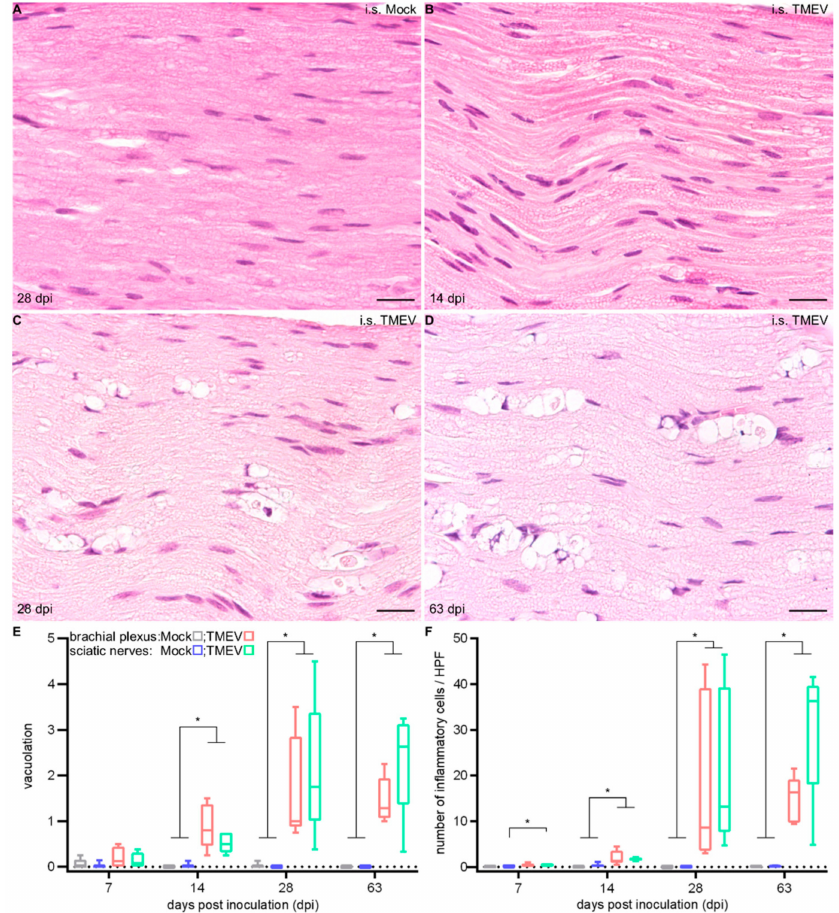
Figure 5. Histopathogical examination of the peripheral nerve (PN) at 28 days post i.s. mock-injection ( A ) and at 14 ( B ), 28 ( C ) and 63 ( D ) days post i.s. TMEV infection. PN showed vacuolation ( E ) and inflammation ( F ). Graphs display the weighted average of left and right brachial plexus or sciatic nerves, respectively. Box-and-whisker plots show median and quartiles. Significant di ff erences between the groups as detected by a Mann–Whitney U-test are indicated by asterisks (* p < 0.05). Hematoxylin and eosin, bars represent 20 µ